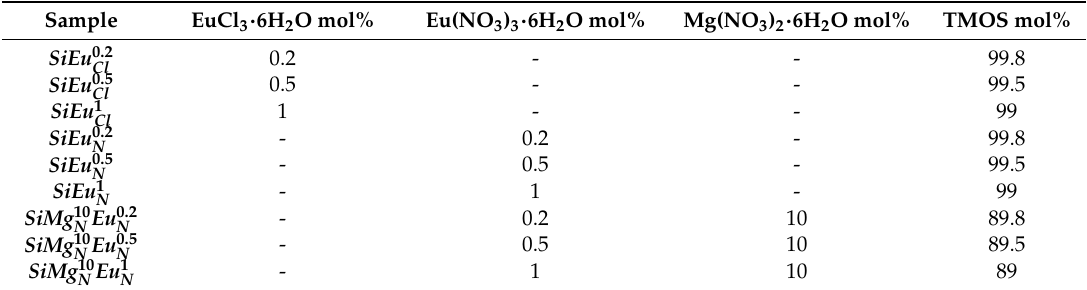
Table 3. Starting composition and nomenclature of mixed